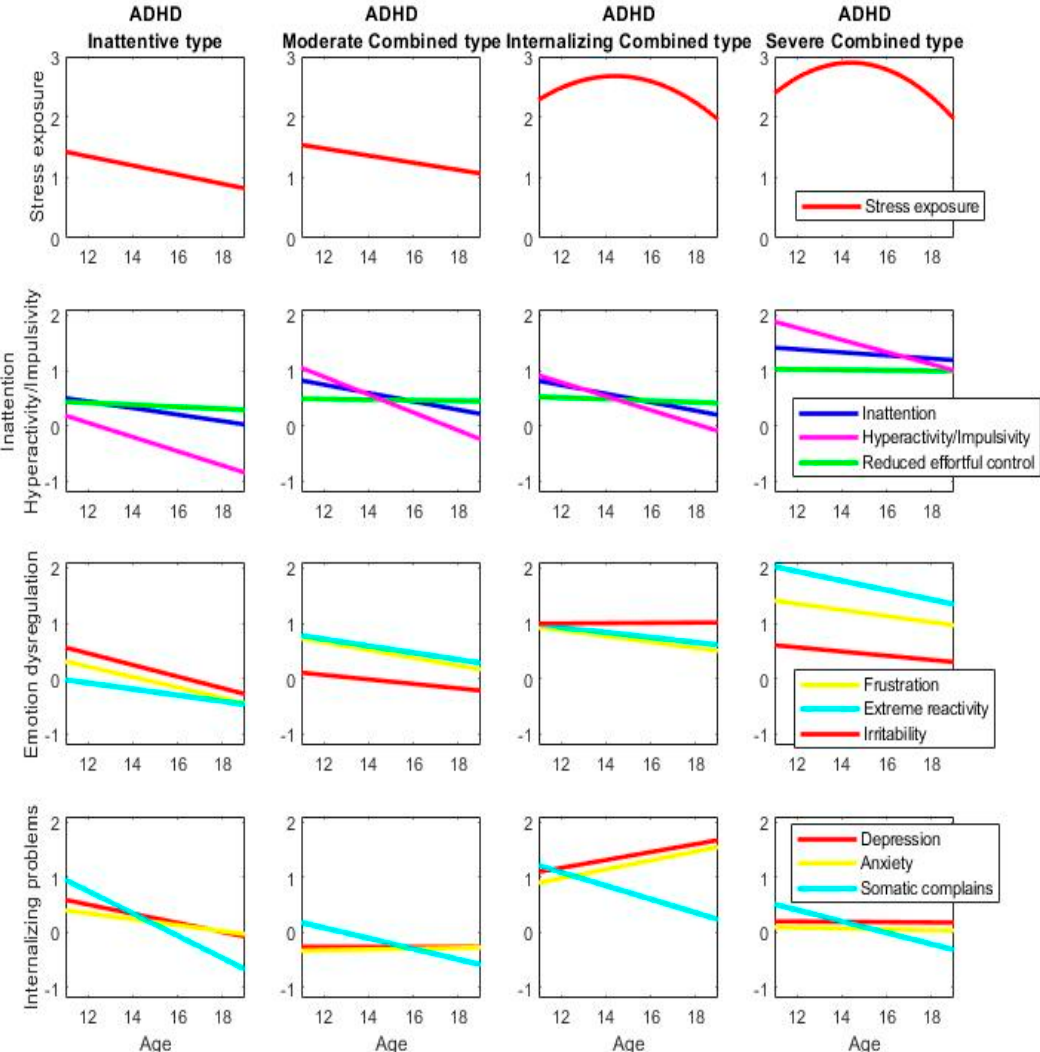
Figure 1. (standardized results). Results of the multivariate latent class growth analysis identifying seven subgroups that differed over the course of stress exposure, core attention-deficit-hyperactivity disorder (ADHD) symptoms, effortful control, and internalizing and emotional regulation problems measured at ages 11, 13, 16, and 19. Unstandardized estimates are plotted for each subgroup (left to right) on trajectories across the four domains (top to bottom).